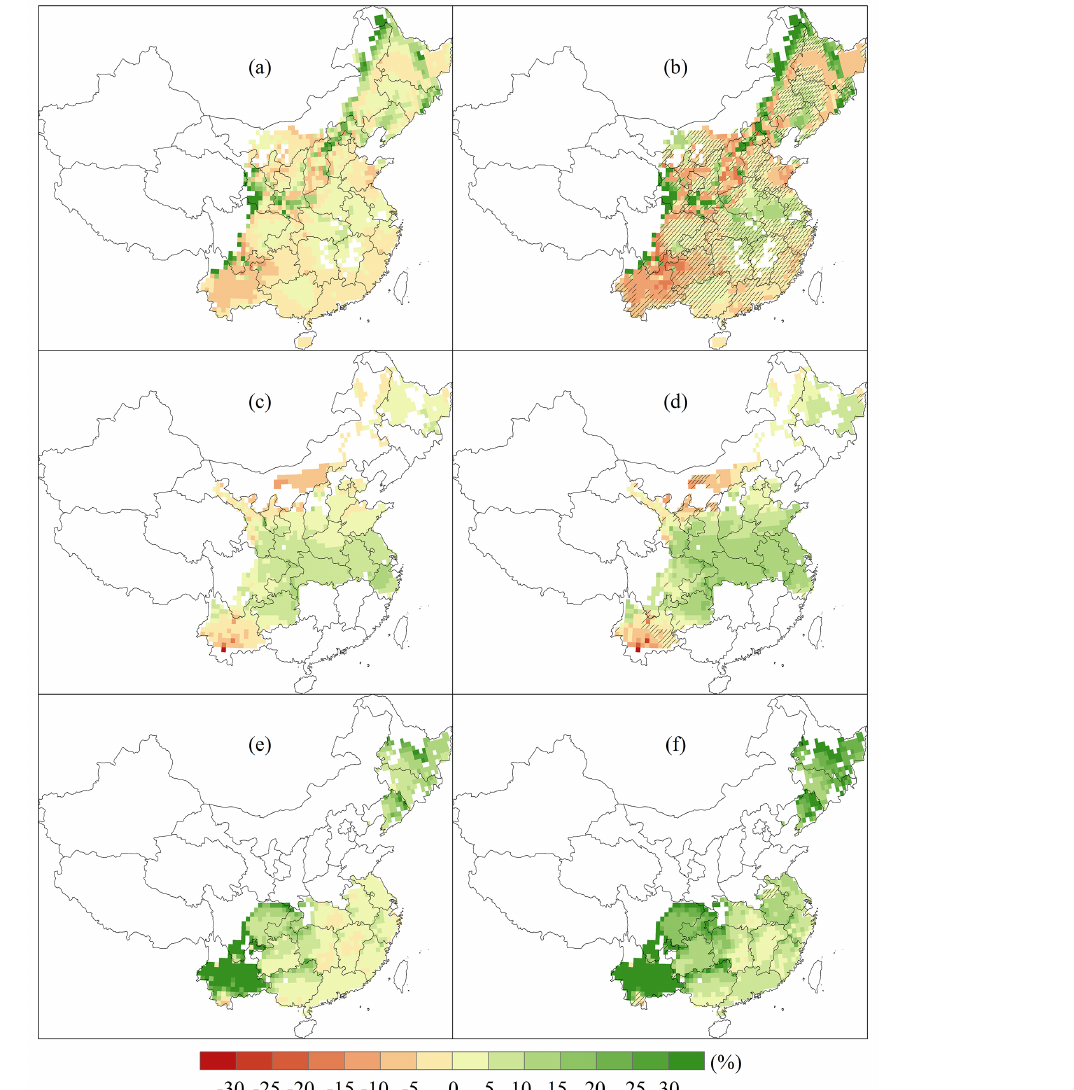
Figure 5. Median changes in projected yield for maize (a, b) , wheat (c, d) and rice (e, f) during 2106–2115 under the 1.5 ◦ C warming (a, c, e) and 2.0 ◦ C warming (b, d, f) scenarios relative to 2006–2015, taking the CO 2 fertilization effect into account. Hatching indicates the areas where the differences between the 1.5 and 2.0 ◦ C warming scenarios are not significant ( P > 0 .